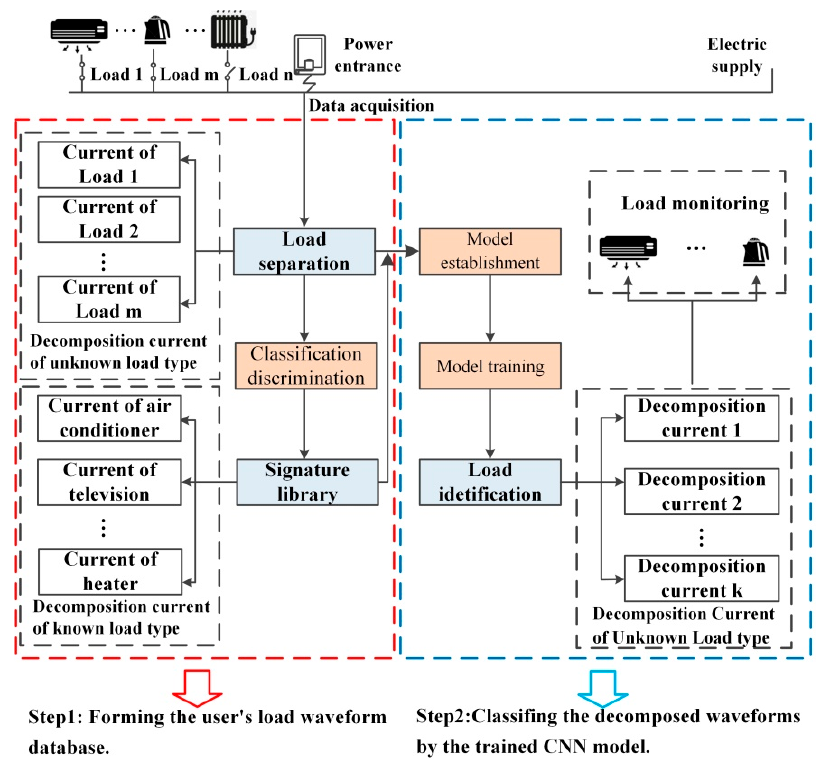
Figure 2. Non-intrusive load identification implementation structure.